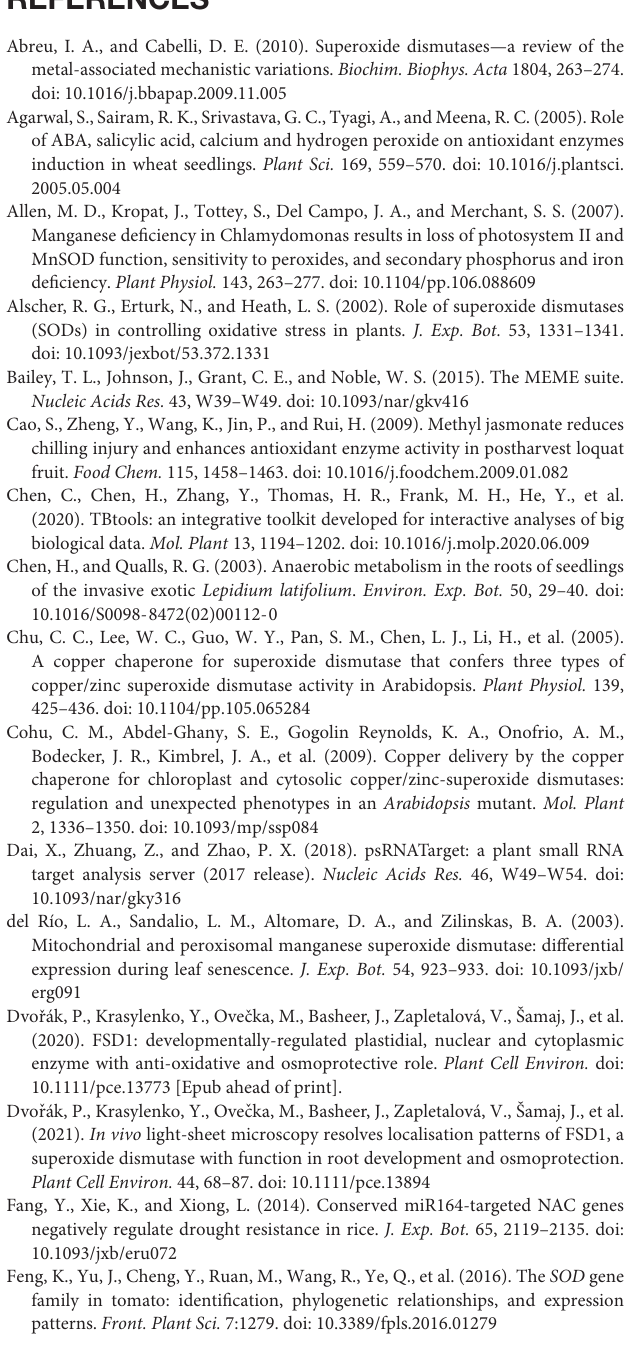
indicates the conservation of the amino acid in the protein. The height of a letter indicates its relative frequency at the given position (X-axis) in the motif. Supplementary Figure 2 | Expression patterns of the tobacco NtSOD genes in various tissues. Heatmap generated with TPM values. The depth of the red color in the figure reflects the levels of gene expression. Supplementary Figure 3 | Distribution of cis -acting element positions in NtSOD